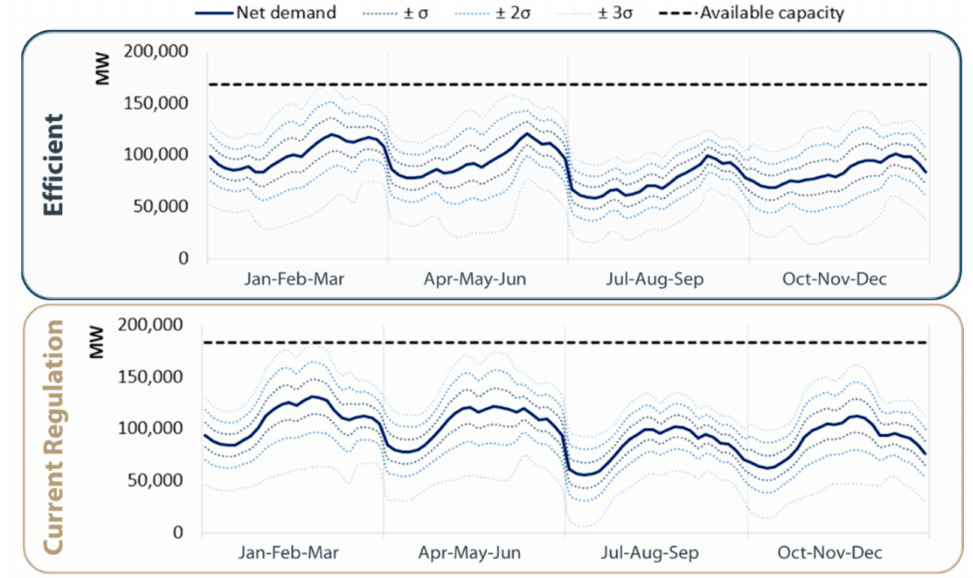
Figure 13. Comparison of the system reliability level between